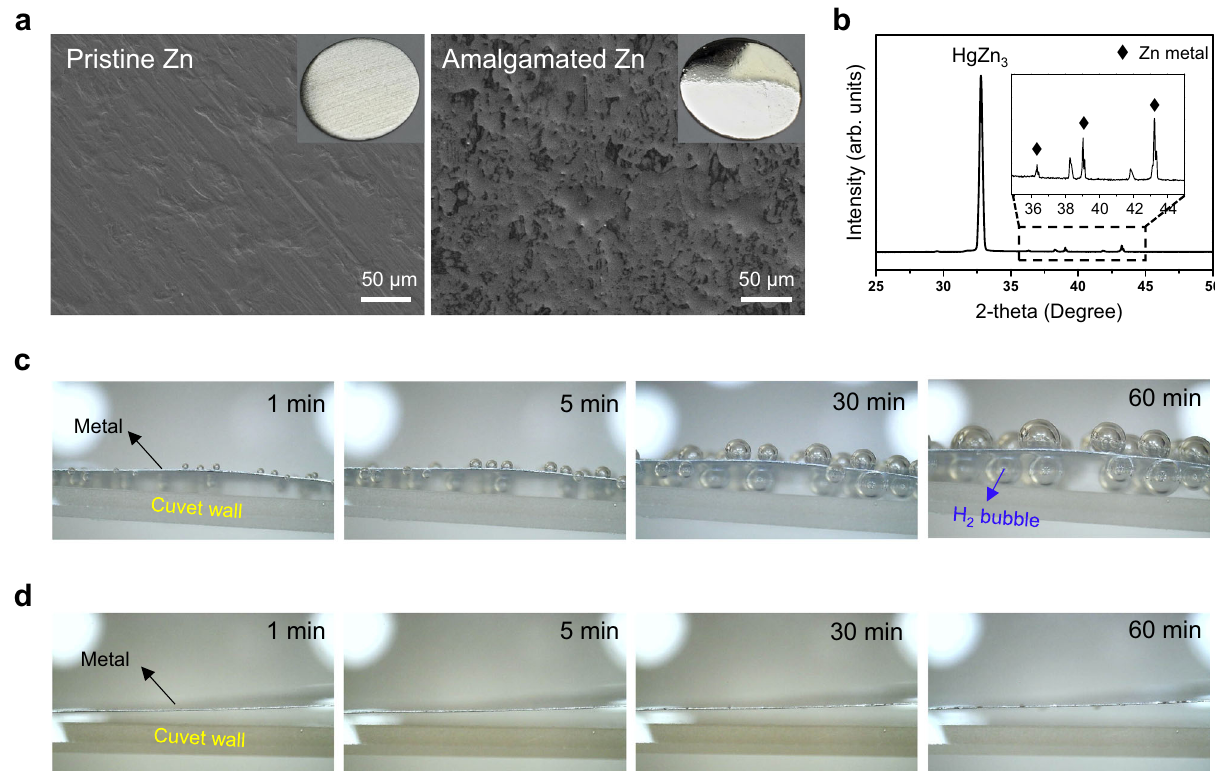
Fig. 5 Preparation of amalgamated Zn and its corrosion resistance. a SEM images of pristine Zn metal and amalgamated Zn metal. The insets are optical photographs of the corresponding metals. b XRD pattern of as-prepared amalgamated Zn metal. c , d Magni fi ed digital photographs of metal electrodes in 0.01 M HCl ( aq ) ( = pH 2) after different periods of time. c Pristine Zn and d amalgamated